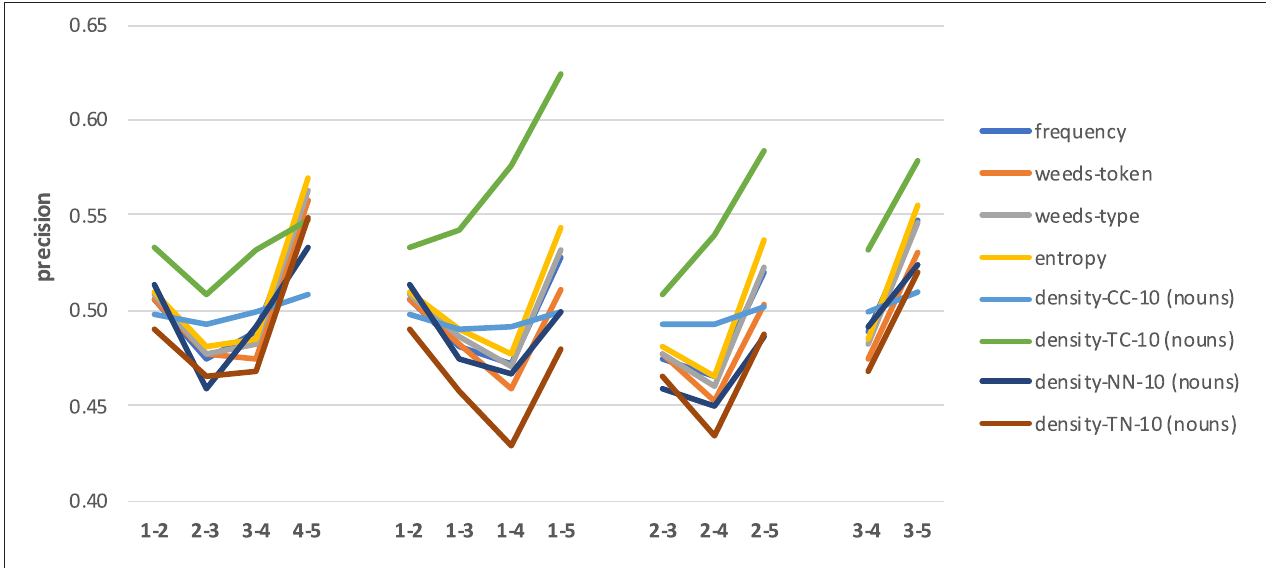
FIGURE 10 | Results across combinations of concreteness ranges for